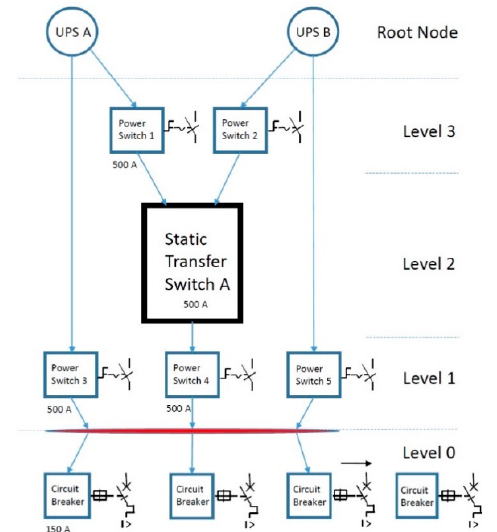
Figure 3. Node tree diagram with internode of a power supply block.